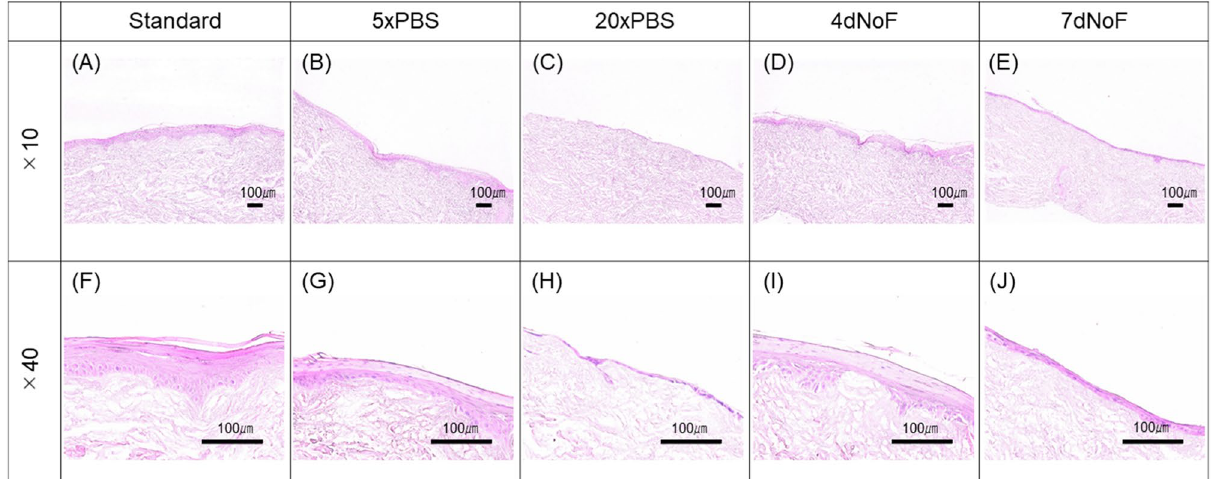
Figure 6. Histologic analysis of the EVPOME received metabolic challenges compared with the standard protocol. Representative histologic appearances of the EVPOMEs consisted of oral keratinocytes cultured under standard or four different metabolic challenge protocols in a 2D culture condition before transfer to a 3D culture condition. Oral keratinocytes grown in the standard protocol developed a well-differentiated, stratified epithelial layer on the scaffold ( A , F ). Compared with those histologic features, however, cells that received mild metabolic challenges, such as 5×PBS and 4dNoF, formed a thinner epithelial layer ( B , D , G , I ). Furthermore, cells that received severe metabolic challenges, such as 20×PBS and 7dNoF, generated a poorly differentiated epithelial layer ( C , E , H , J ). Additionally, some failed to generate a continuous epithelial layer. Haematoxylin and eosin